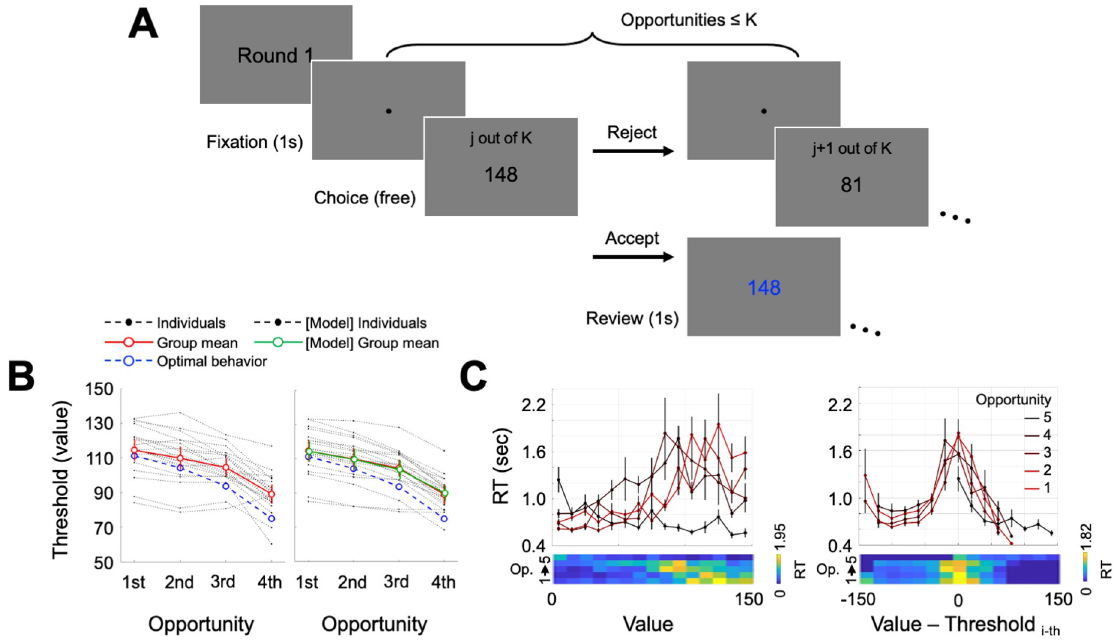
Fig 1. Experimental procedures and behavioral results of Experiment 1. (A) Participants made a series of choices between accepting and rejecting a presented number. At each round, they had up to K opportunities (K = 5 in Experiment 1, K = 2 or 5 in Experiment 2) to reject the number and get a new random number; the round ended when participants accepted a presented number. At the last opportunity, participants were given no choice but to accept the presented number. A new set of stimuli (numbers) was used in the next round. (B) The optimal decision threshold per opportunity (blue), calculated under the assumption of the full information, was compared with a corresponding empirical decision threshold (red). (C) Response times (RTs) for each opportunity were computed against the presented stimuli values. Regardless of the opportunity, RTs showed negative association with the absolute distance between the presented stimuli and the corresponding decision threshold. That is, participants showed the shortest RTs for the numbers that are farthest from decision thresholds, and vice versa. Error bars represent